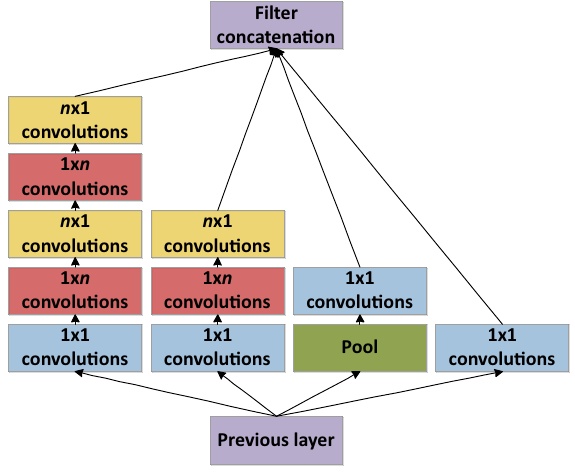
Fig. 4 Inception module after factorization of n × n convolutions.